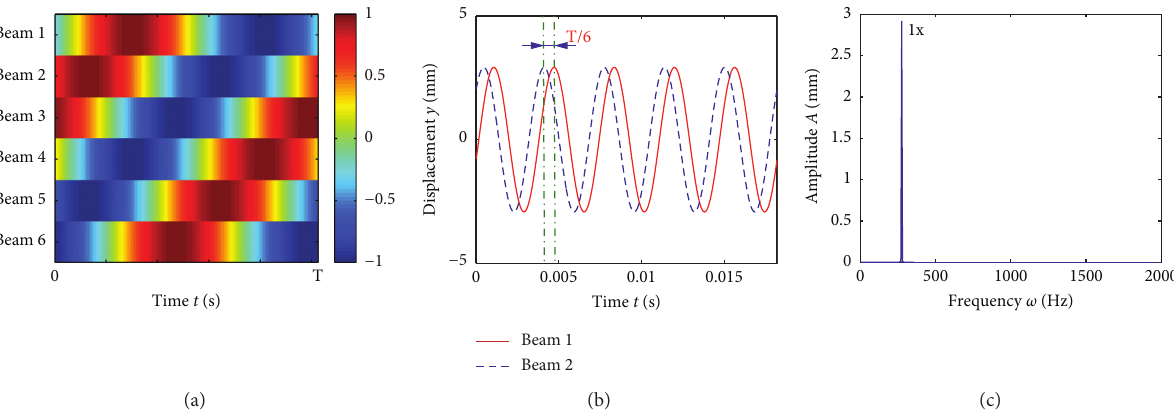
Figure 8: The response of beam tip for Ω � 400 rad/s: (a) response of beam 1 to beam 6, (b) response curve of beam 1 and 2, and (c) spectrum plot of beam